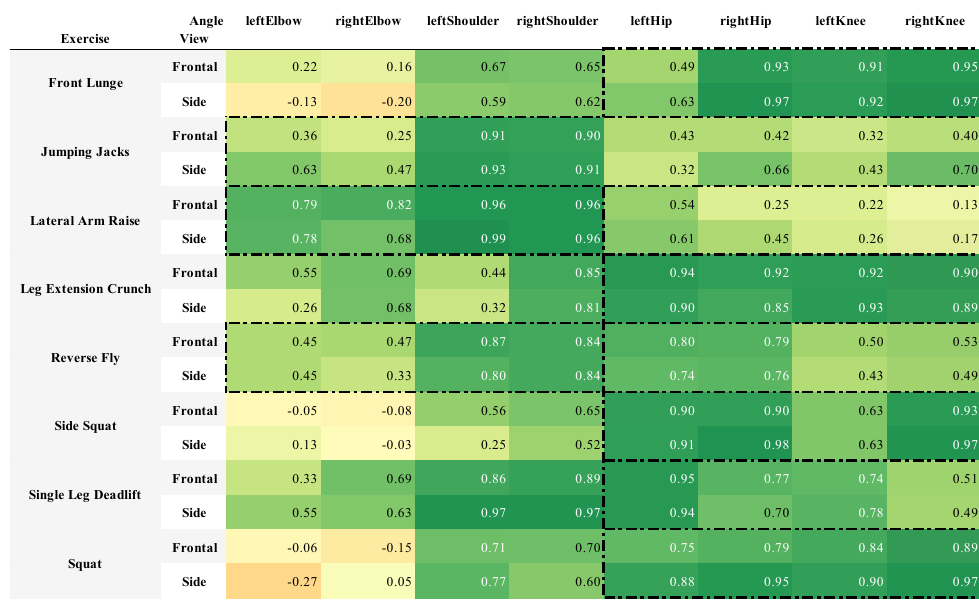
Figure 5. Pivot Table of the average Spearman Rank Correlation Coefficients (SRCC) distributed over the eight exercises and the eight tracked angles, each measured from the two iPad perspectives Frontal and Side . The dashed boxes indicate which joints were specifically targeted by the respective exercise. The heatmap visualizes the performance of the individual joints per exercise, with darker green color referring to a higher positive correlation and darker orange color referring to a higher negative correlation.